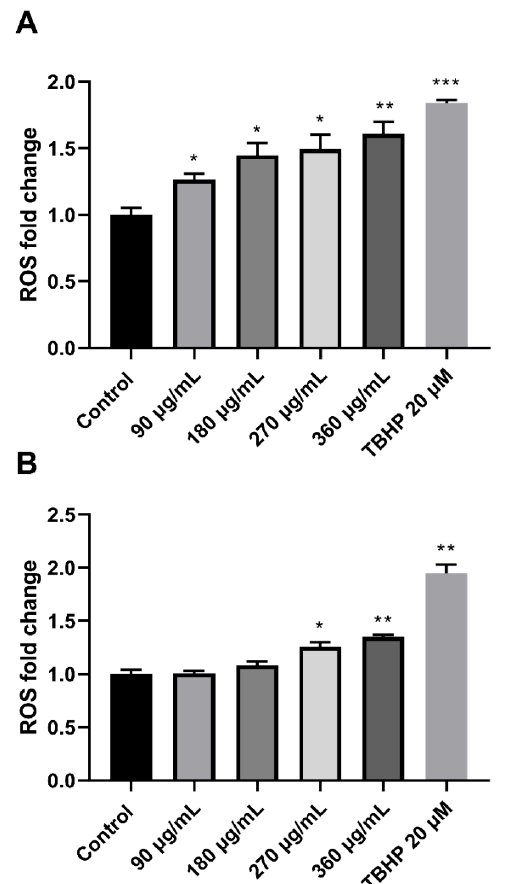
Figure 6. Fold change of ROS in Monomac-1 ( A ) and KG-1 cells ( B ) treated with increasing concentrations of MMLE and a positive control treated with 20 μ M of TBHP. ROS levels increased significantly with increasing concentration of MMLE for both Monomac-1 (A) and KG-1 cells (B). Significance relative to the negative control was reported with * indicating a p -value: 0.01 < p < 0.05, ** indicating a p -value: 0.001 < p < 0.01, and *** indicating a p -value: 0.0001 < p < 0.001.